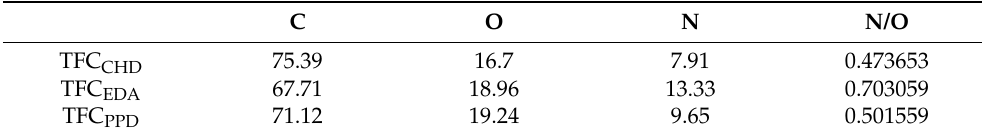
Table 1. Elemental analysis of TFC membranes using XPS.